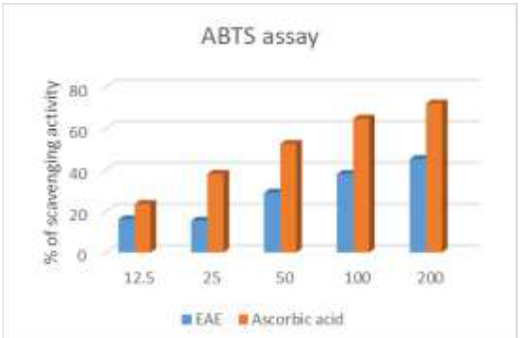
Figure 7. The antioxidant activity of EAE measured by ABTS method and compared with ascorbic acid standard: (EAE) ethyl acetate extract of Iraqi C.grandiflora , (ABTS assay ) 2,2'azino–bis(3–ethylbenzothiazoline–6– sulphonic acid) diammonium salt.